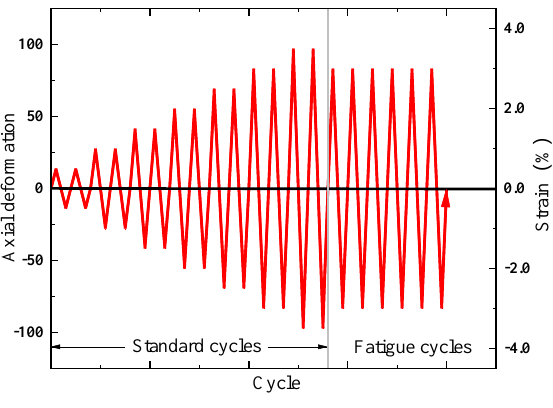
Table 3. Parameters of concrete damaged plasticity model.